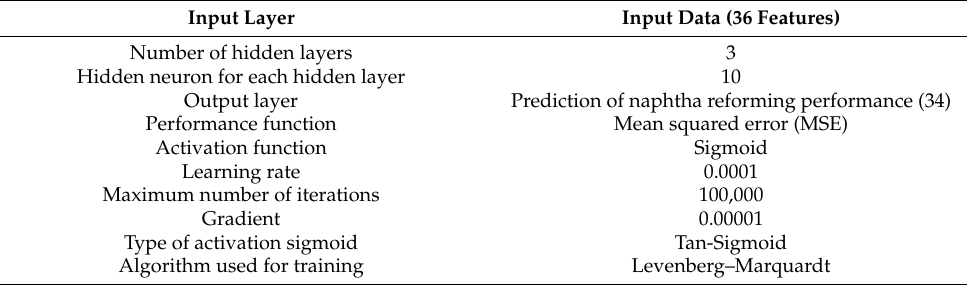
Table 5. Parameters of the artificial neural network